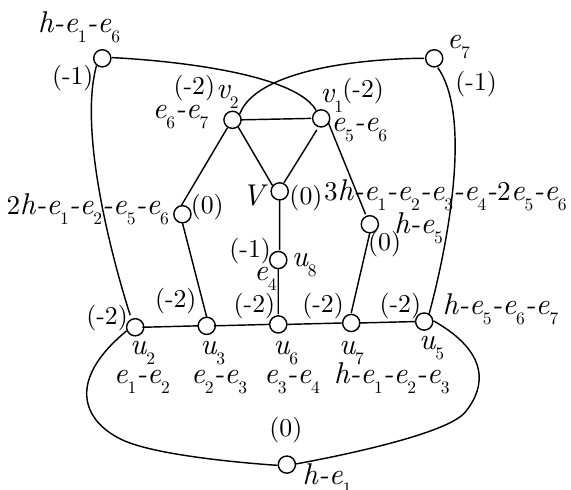
Figure 24 . The con(cid:12)guration of curves in the example geometry E 6 (cid:2) SU(3), including the rational ( (cid:0) 2), ( (cid:0) 1) and